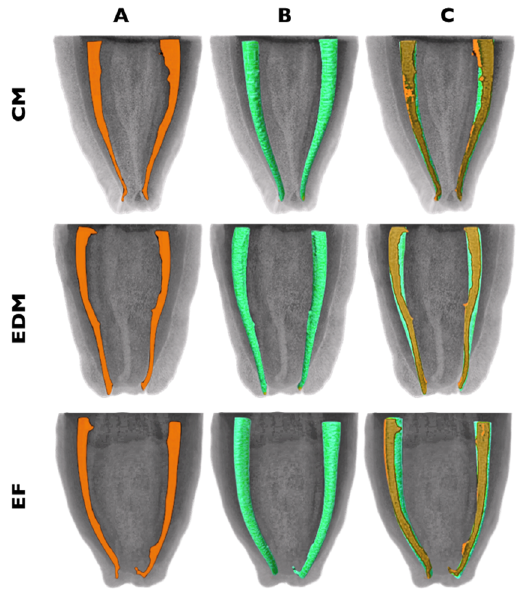
Figure 3. 3D illustrative examples of the shaping ability of the thermally treated instrument systems: preoperative ( A ), postoperative ( B ) and superimposed reconstructions ( C ).